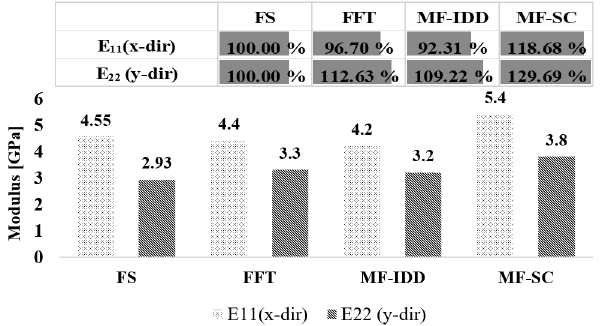
Figure 5. Comparison of prediction results for homogenization theory.